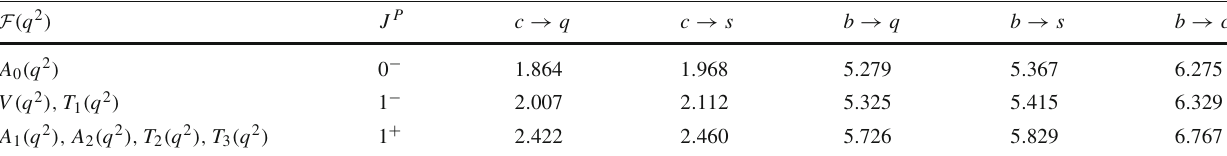
Table 2 The summary of the resonance masses (in units of GeV) with different quantum numbers entering the z -series expansions of the P → T form factors